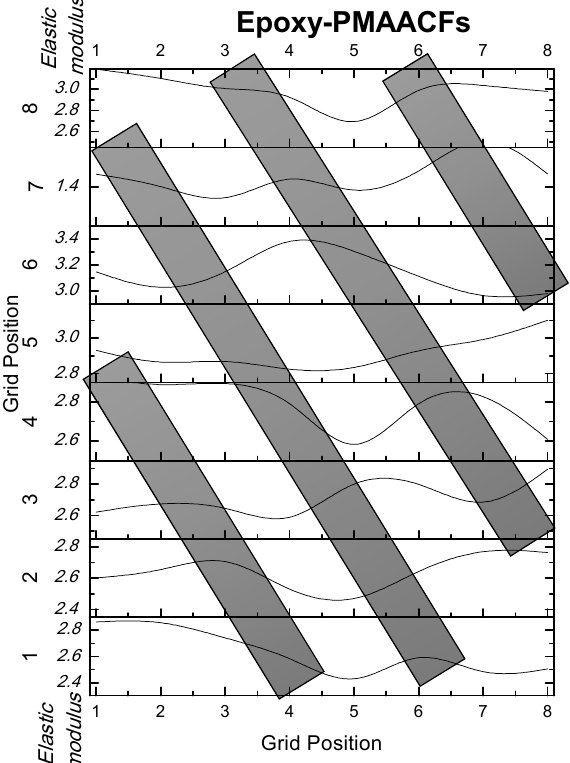
Figure 12. Identification of fibre orientation through elastic modulus nanoindentation mapping measurements at 200 nm of displacement for the epoxy ‐ PMAACFs sample (fibres in grey). Value increases represent the fibres underneath the indenter, while value decreases represent the area in between fibres.